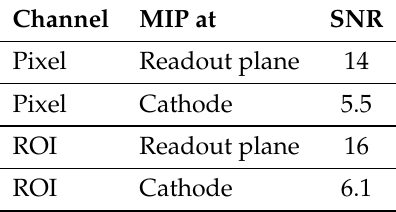
Table 1. SNR values obtained from Equation (2) using the theoretical signal of a MIP at the readout plane or cathode, respectively combined with the average equivalent noise charge for pixel and ROI channels obtained from